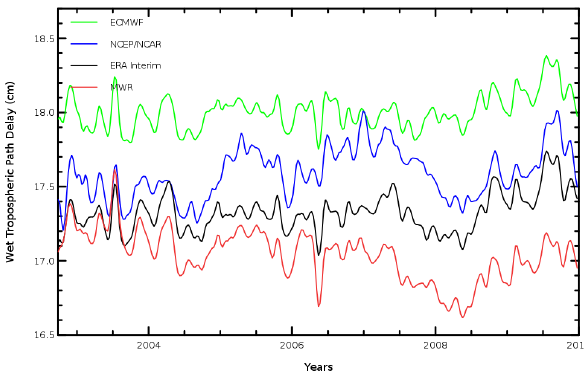
Figure 9. Time series of wet path delays (opposite of the wet troposphere correction, in cm) derived from the Envisat MWR radiometer, the ERA Interim and NCEP/NCAR reanalyses and the operational ECMWF model. Data at latitudes lower than 66 ◦ are selected and time series are 2-month-filtered and adjusted from annual and semiannual signals.